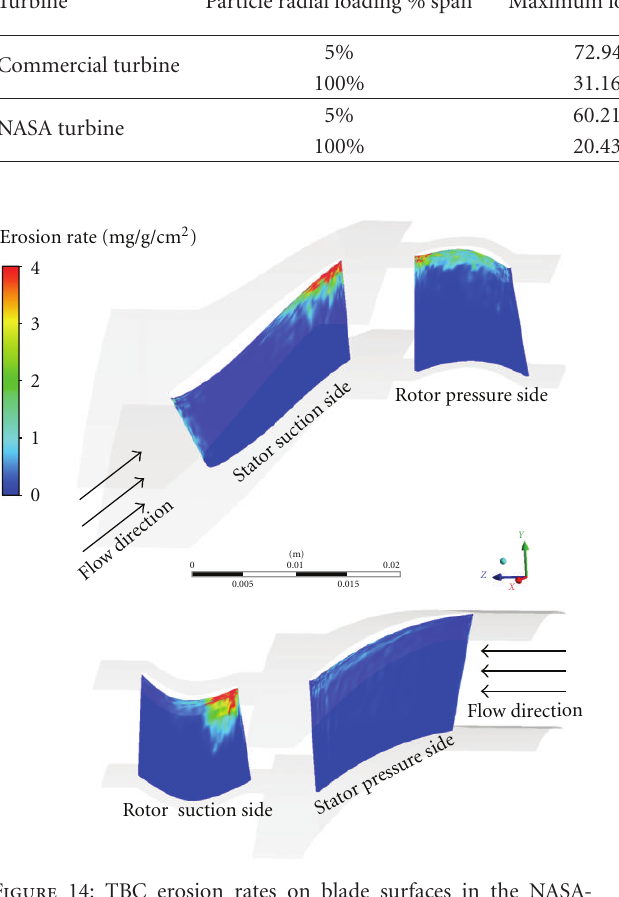
Table 3: Computed overall blades and maximum local TBC erosion rates on the commercial turbine and the NASA-designed turbine. Turbine